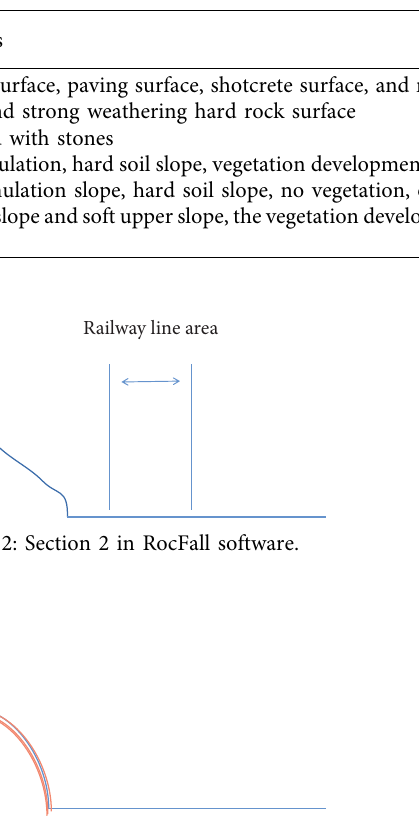
Table 1: Te selection range of the proposed restoration coefcient of Ye Si Bridge.